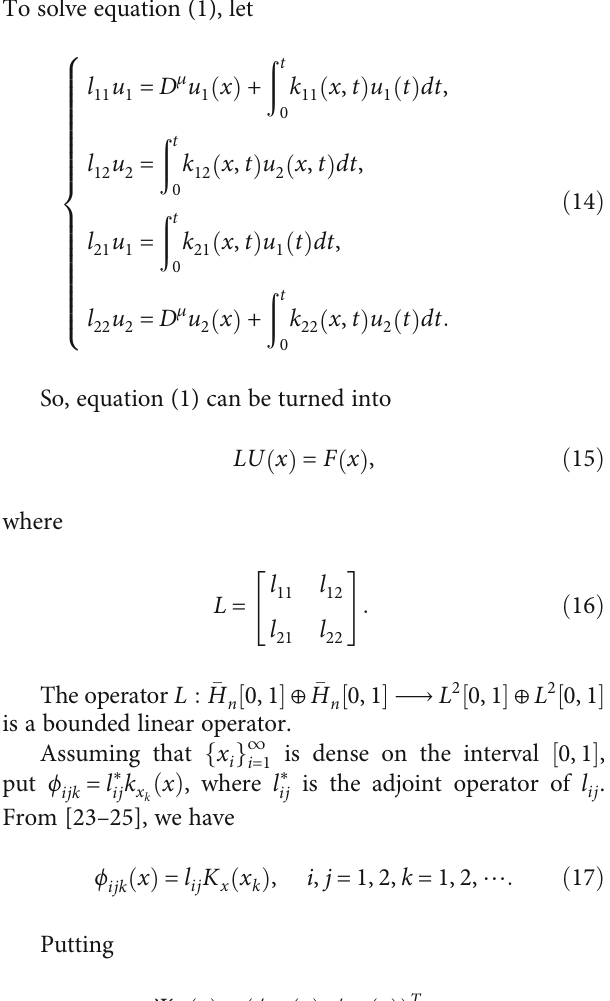
Figure 3: Reproducing kernel R